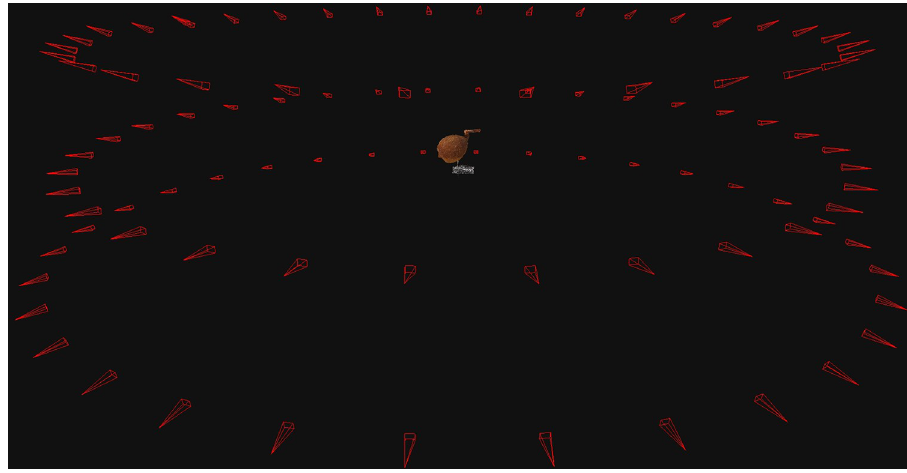
Fig 2. Camera position estimated by 3D Zephyr Lite. 97 images of the fruit of Ficus pumila Linnaeus (PH013) were captured from 0˚, 20˚, and -20˚ vertically towards the carpological material, with at a horizontal rotation interval of 11.25˚. The red triangles represent the camera positions estimated by 3D Zephyr Lite.